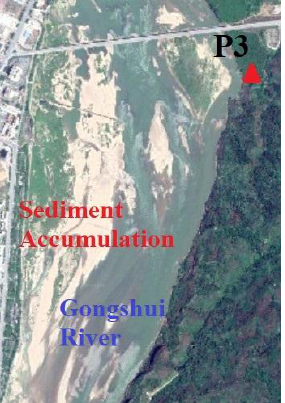
Figure 13. Satellite imagery and surface subsidence rate around